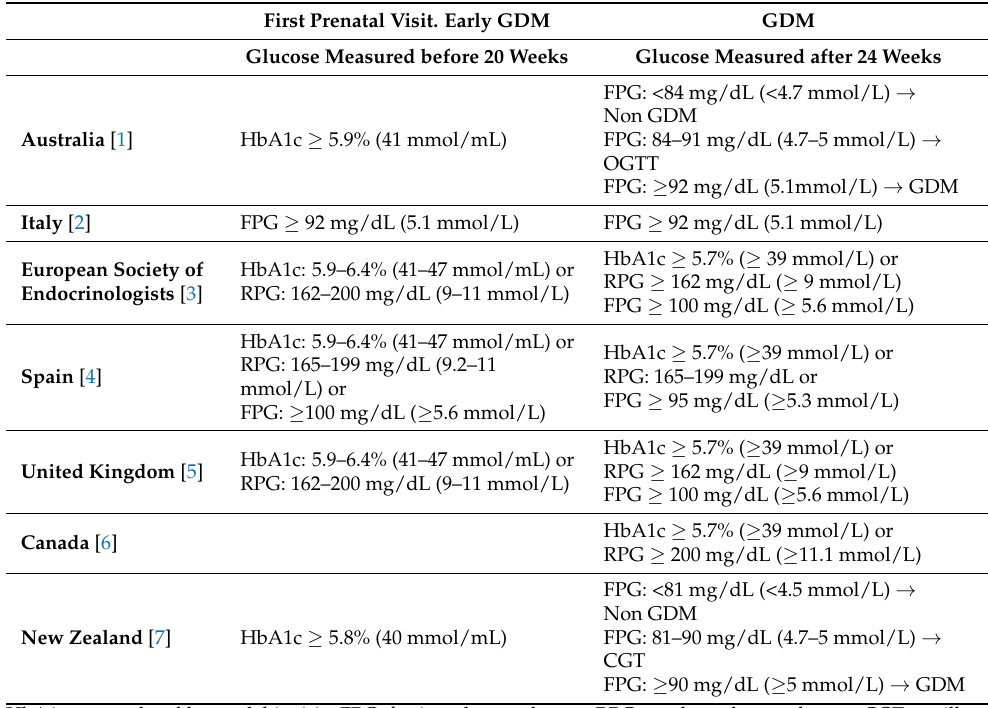
Table 1. Summary of the different recommendations for the diagnosis of gestational diabetes mellitus (GDM) during the COVID-19